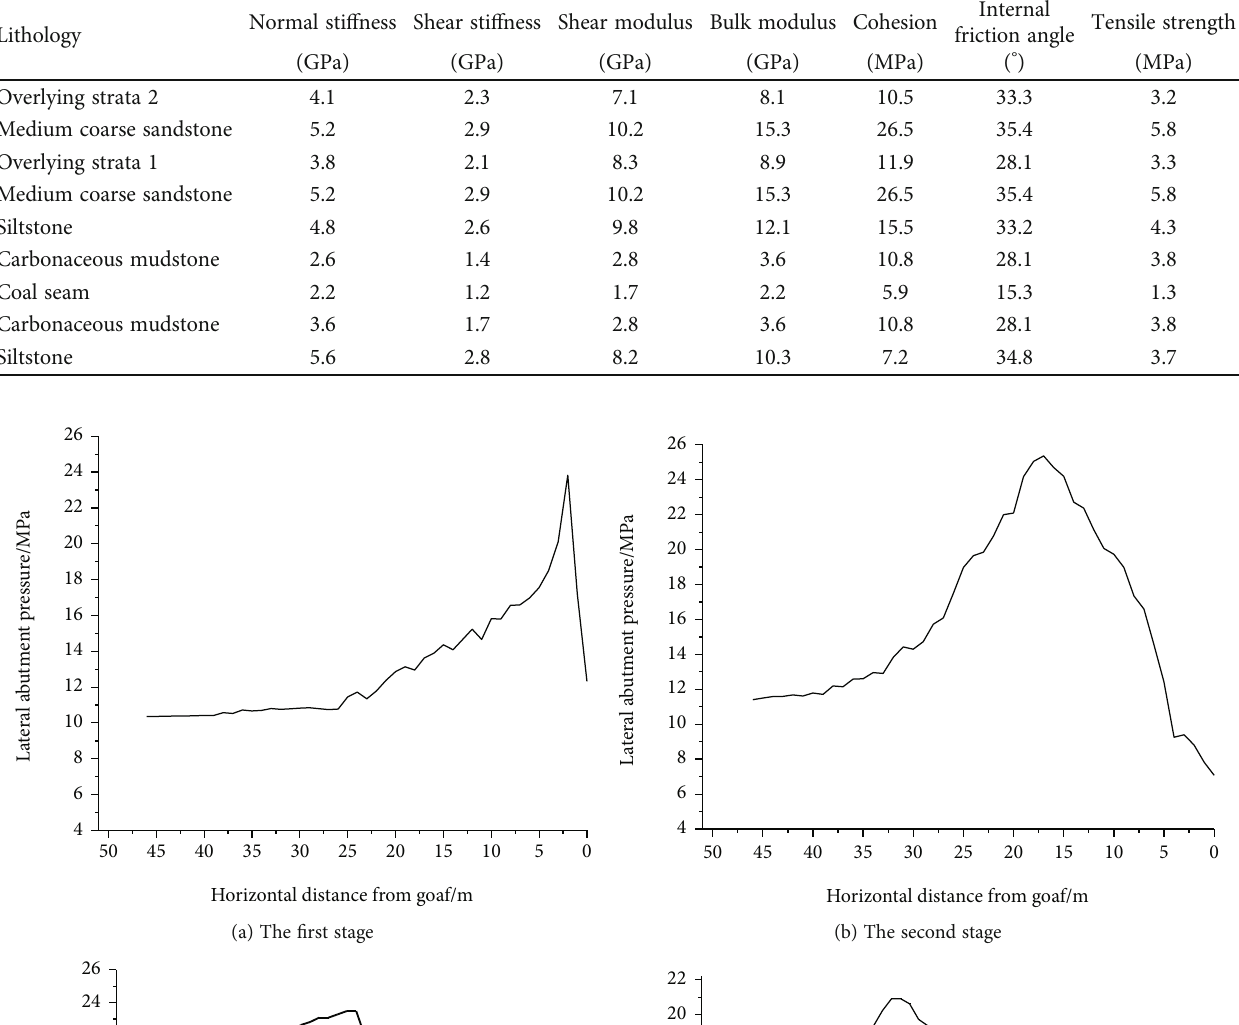
Table. 2: Joint mechanical parameters of coal and rock.